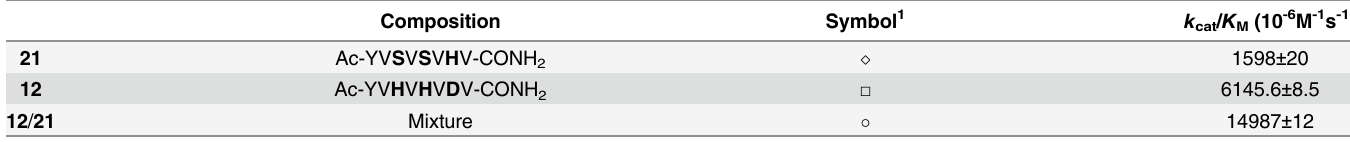
Table 4. Esterase activity of selected peptides at pH